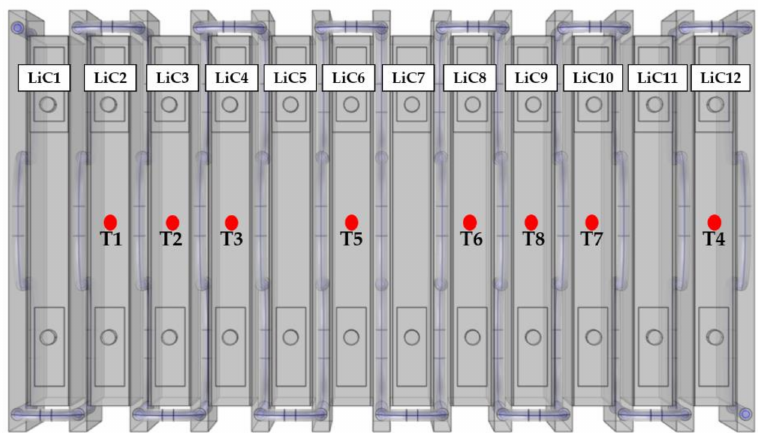
Figure 8. The position of 8 K-type thermocouples regarding their temperature values; T1 is the lowest and T8 is the hottest (top